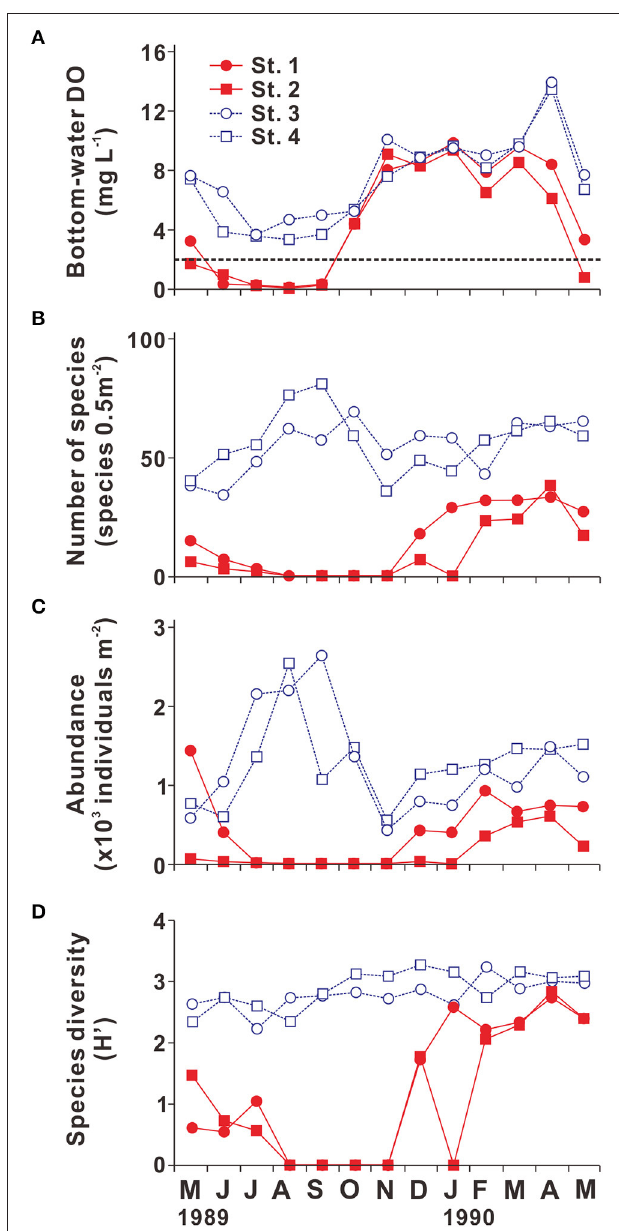
FIGURE 5 | Seasonal variation in (A) bottom-water dissolved oxygen (DO; mg L − 1 ), (B) number of species (species 0.5 m − 2 ), (C) abundance ( × 10 3 individuals m − 2 ), and (D) benthic species diversity (Shannon diversity index) in Jinhae Bay. The dotted line in (A) represents hypoxia (DO < 2mg L − 1 ). Samples were collected at the four stations marked (by plus signs) in Figure 2 . Source: Modified from Lim et al. (2006).